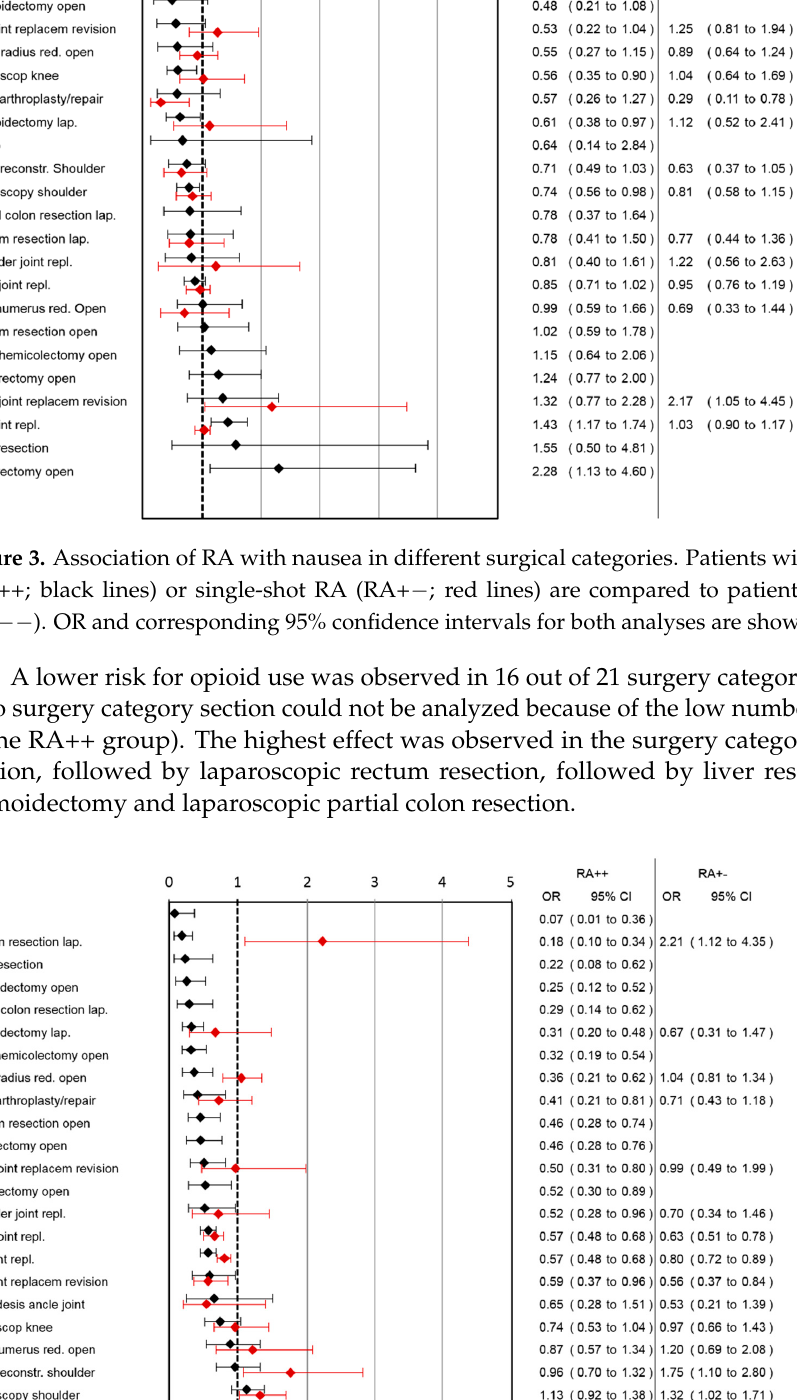
Figure 2. Association of RA with pain-associated impairment of mobilization in different surgical categories. Patients with continuous (RA++; black lines) or single-shot RA (RA+ − ; red lines) are compared to patients without RA (RA −− ). OR and corresponding 95% confidence intervals for both analyses are shown.